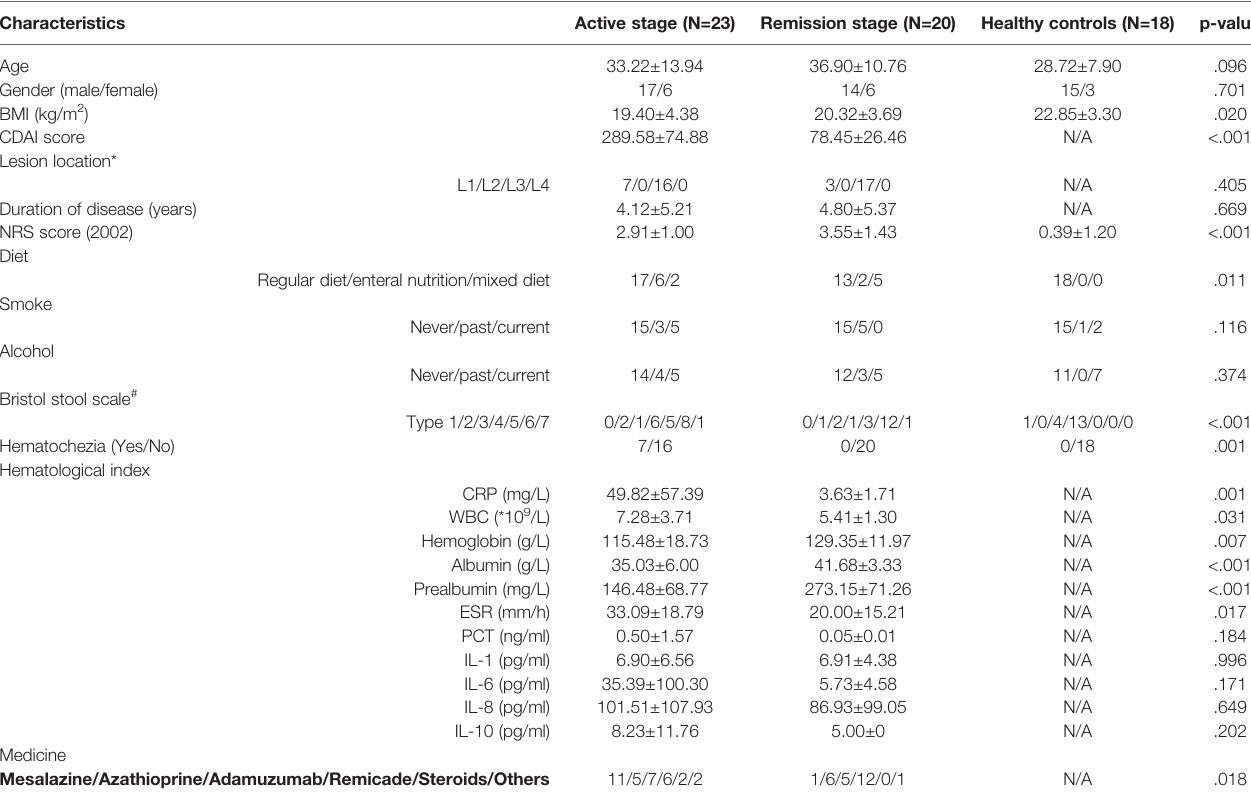
TABLE 1 | Baseline demographic and clinical characteristics of patients with CD and healthy controls.